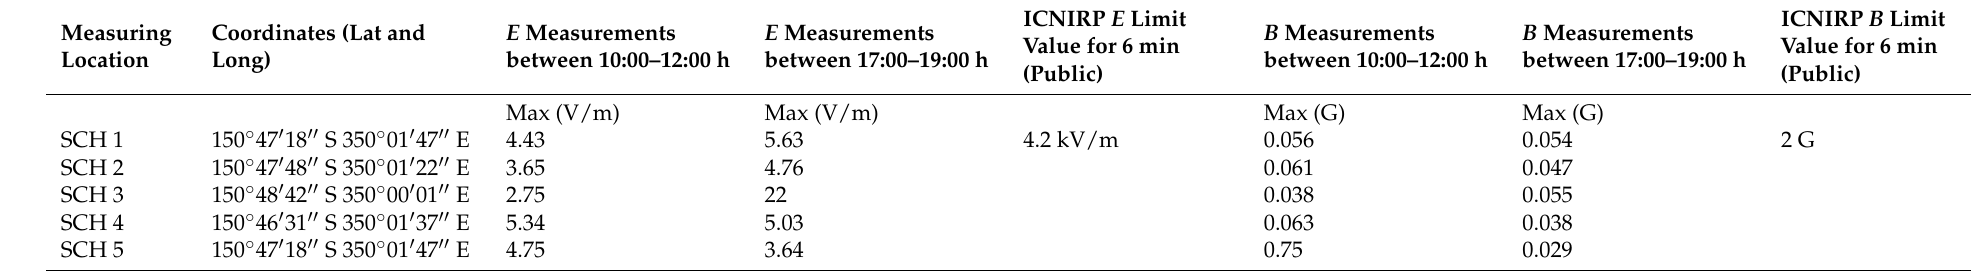
Table 4. Statistical results of E and B in school campuses.